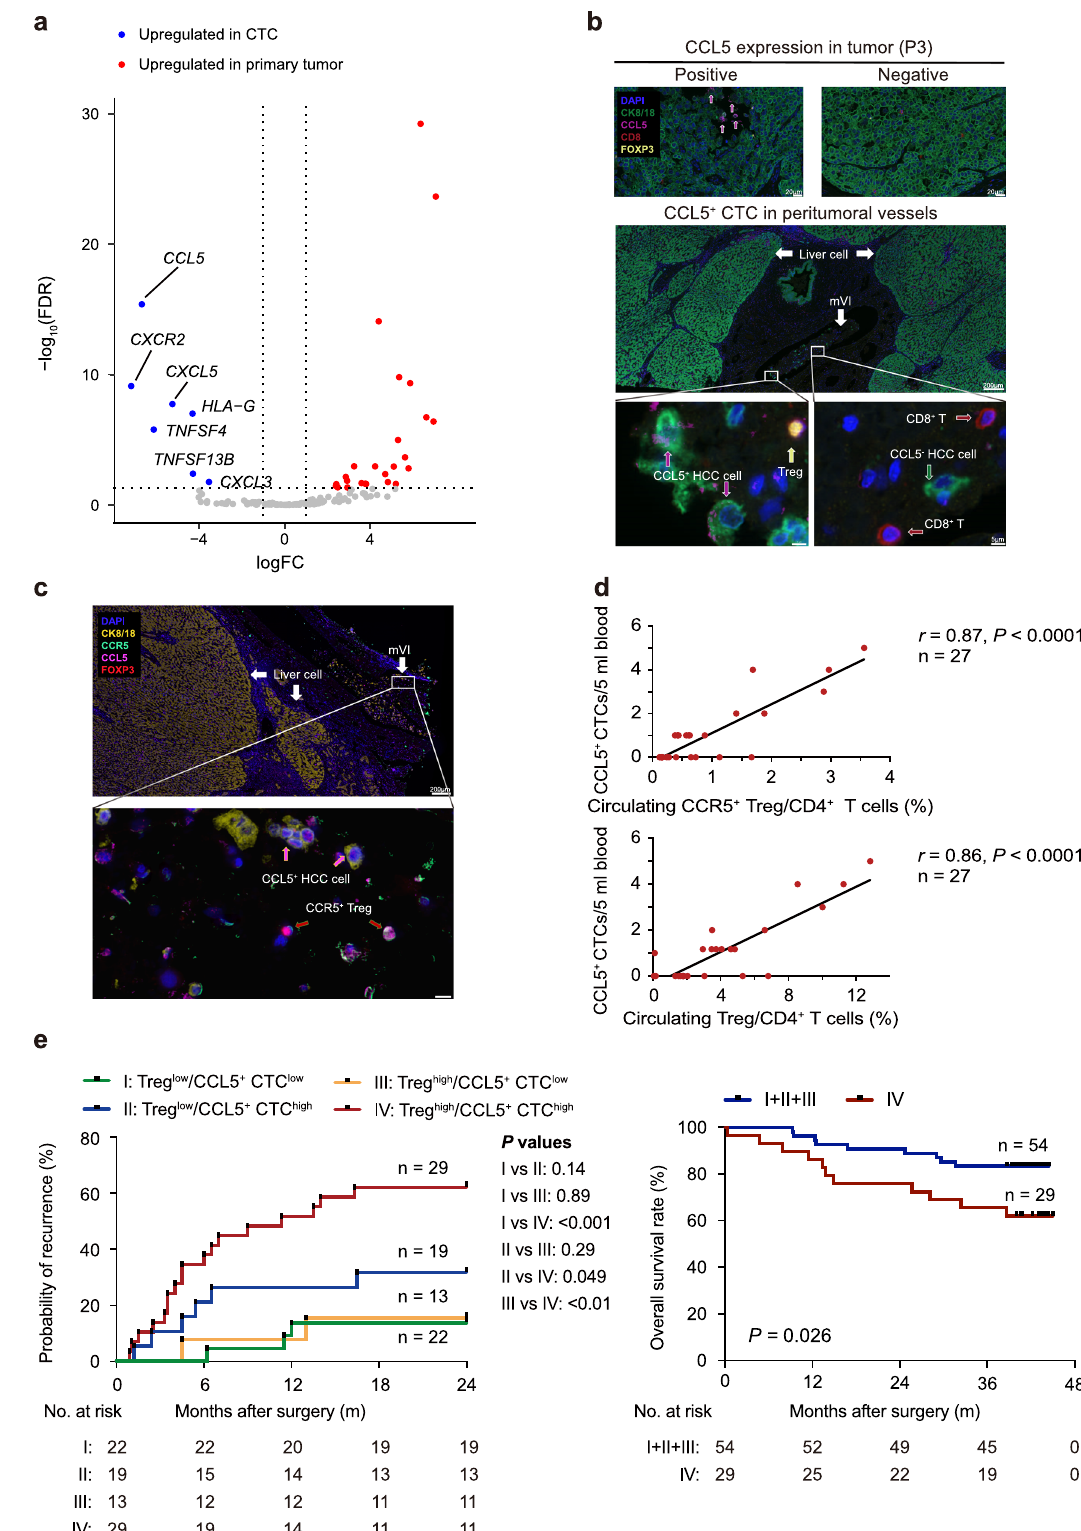
CTCs exploit a self-defensive mechanism by recruiting Tregs via CCL5 to establish a metastatic-favorable microenvironment during hematogenous transportation. CCL5 induction is mediated through p38-MAX signaling . To identify a candidate regulator of CCL5 induction, we fi